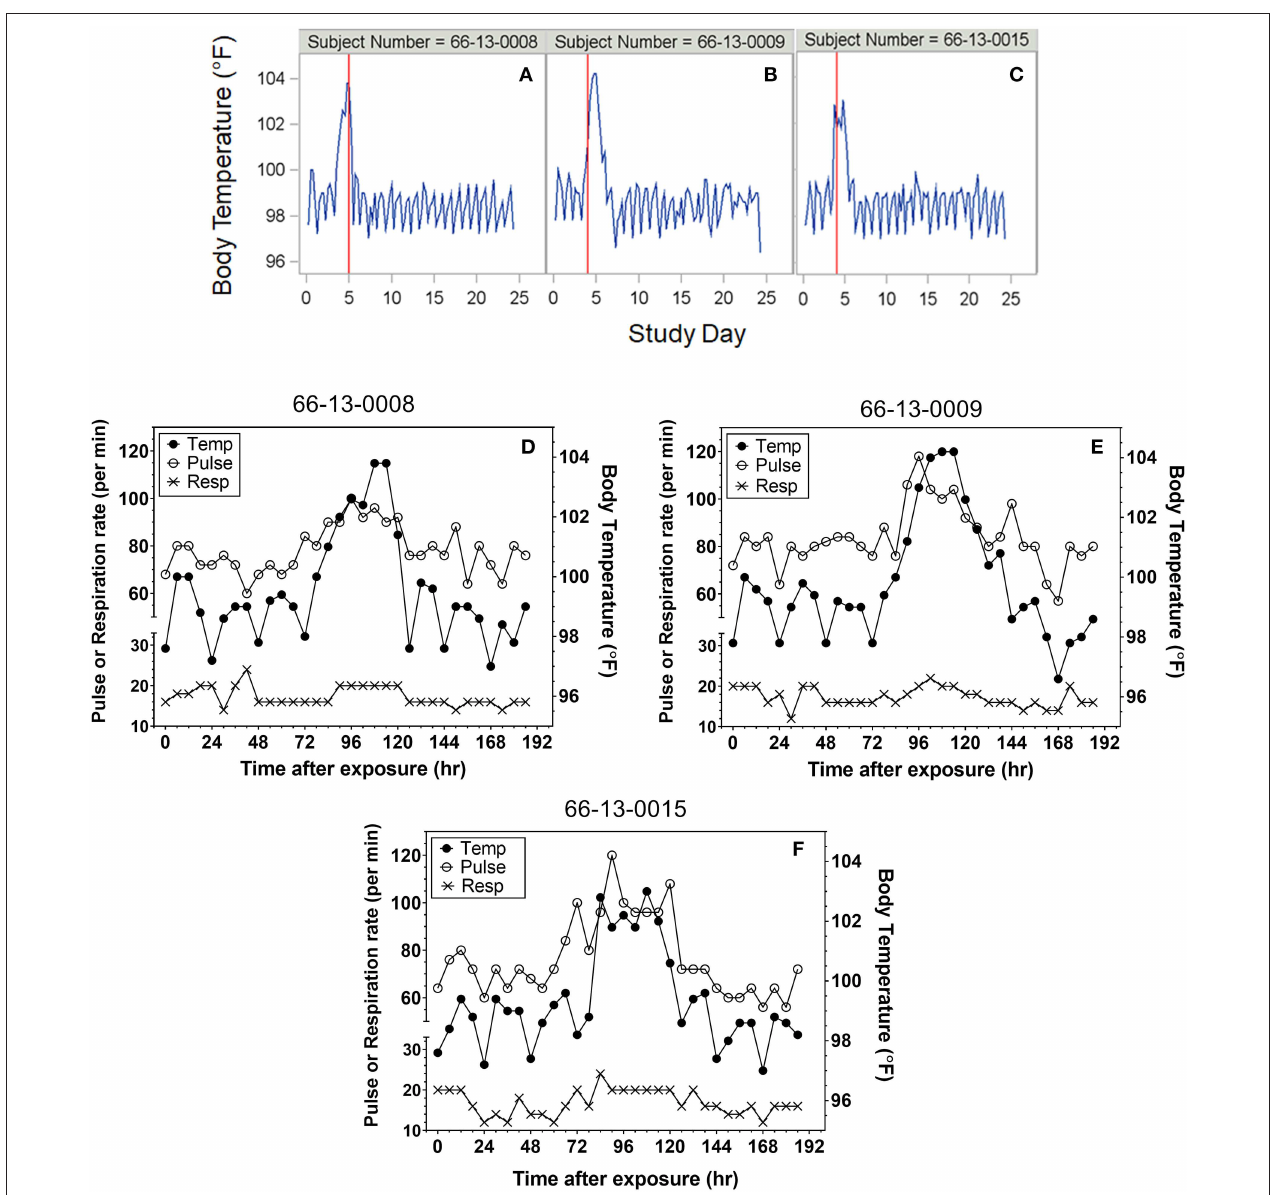
FIGURE 1 | Representative plots of vital signs for subjects exposed to 25,000 cfu. (A–C) Representative temperature plots derived from body temperature (in ◦ F) listings over the entire course of the study. The red vertical line represents the study day (@ 000h) where antibiotic was administered. (D–F) Overlay plots for the same subjects in which body temperature changes (closed circles, in ◦ F) are plotted with pulse rate (open circles) and respiration rate (X) over the first eight study days after exposure.